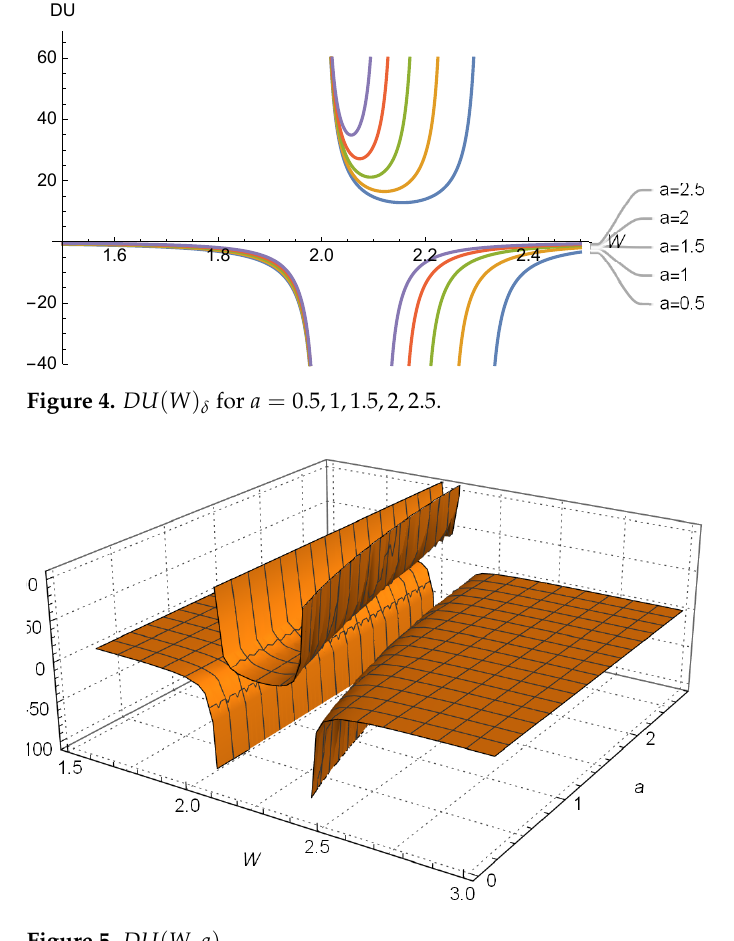
Figure 5. DU ( W , a )